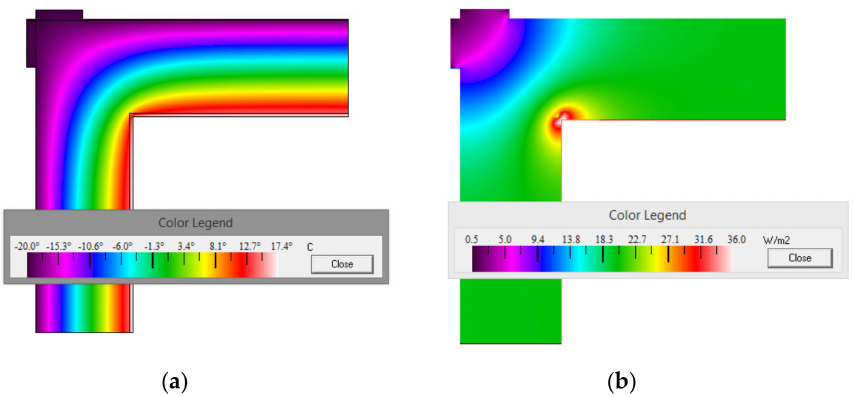
Figure 17. Comparison of calculation results for a wall made from horizontal logs with a thermal insulation layer 11 cm thick ( a —isotherm layout, b —heat stream density distribution).